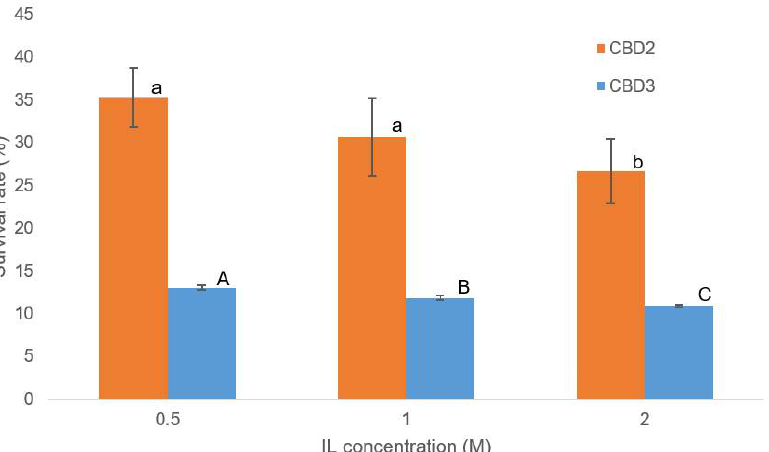
Figure 6. The survival rate of CBD2 and CBD3 cells under treatment of [Ch][OAc] at 0.5, 1.0 and 2.0 M. The represented data are the mean of three replicates ± standard error ( p ≤ 0.05). a, b determine statistically difference in survival rate of CBD2. A, B, C determine statistically difference in survival rate of CBD3.